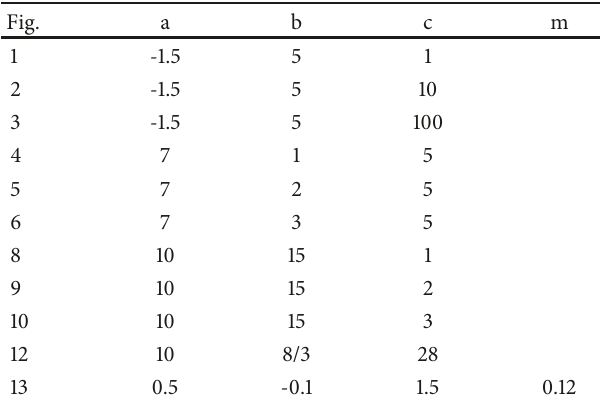
Table 1: Parameters used in the Experiments 1–5.